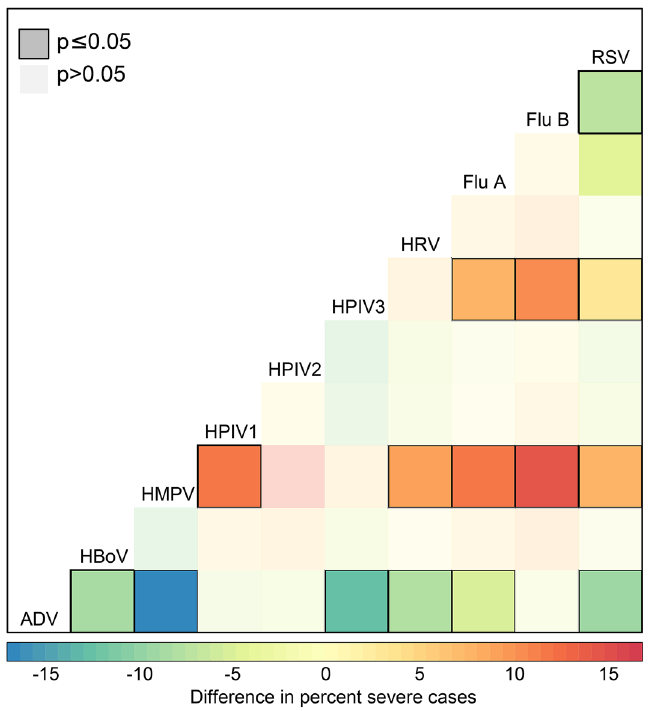
Figure 4. Difference in proportion severe cases between all viruses. Figure shows the difference in percent of patients suffering severe disease (CSS > 3 ) by virus with each other virus. Dark squares outlined in black indicate significant differences between percents as tested by a one-sided proportion test. For example, the bottom row indicates the proportion severe ADV cases is significantly lower than proportions of severe cases from HBoV, HMPV, HPIV3, HRV, Flu A, and RSV. This is comparing mono- and multiply-infected individuals. ADV Adenovirus, HBoV Human bocavirus, HMPV Human metapneumoviruses, HPIV-1, -2, -3, -4